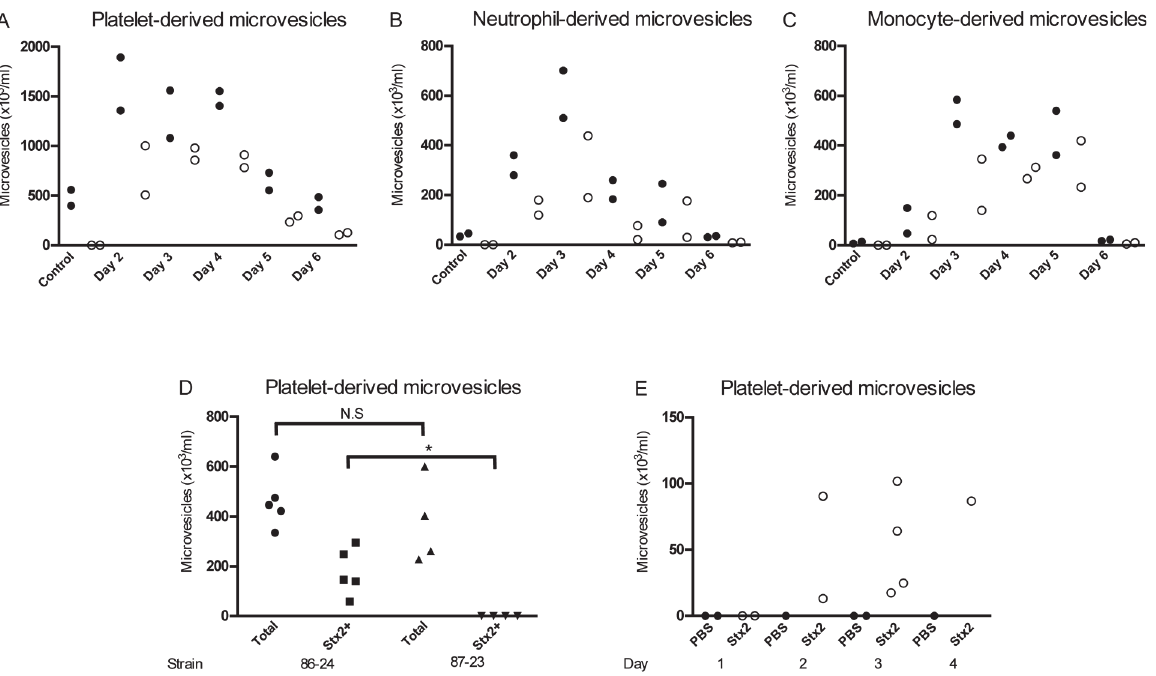
Fig 2. Stx2-containing blood cell-derived microvesicles were detected in the circulation of mice infected with E. coli O157:H7. Microvesicles were isolated from whole blood of BALB/c mice (n = 10) inoculated with the Stx2-producing E. coli O157:H7 strain and analyzed by flow cytometry. Samples were taken between days 2 and 6 after infection. Microvesicles were labeled with anti-Stx2 and anti-mouse CD41:APC ( A ) to identify platelet-derived microvesicles, anti-mouse Ly-6G:PE ( B ) to identify neutrophil-derived microvesicles or a combination of anti-mouse CD45R/B222:PerCp-Cy5.5 and anti- mouse Ly-6G:PE ( C ) to identify monocyte-derived microvesicles. All microvesicles were labeled with cell-specific and Stx2 antibodies. Stx2-containing microvesicles were mostly detected on days 2 – 5 after infection. No labeling of the Stx2 antibody was detected in the non-infected mice (n = 2, day 6). ( D ) Platelet-derived microvesicles (labeled with anti-mouse CD41:APC) and stained for Stx2 were isolated from mice inoculated with Stx2-producing E. coli O157:H7 strain 86 – 24 and the isogenic non-Stx producing E. coli O157:H7 strain 87 – 23 on day 3 post-inoculation. Only mice inoculated with strain 86 – 24 exhibited Stx within microvesicles. * Denotes P < 0.05. ( E ) Platelet-derived microvesicles labelled for Stx2 were isolated from mice injected with Stx2 i.p. or PBS controls. An increase in microvesicles was noted in Stx-treated mice 3 – 4 days after treatment.